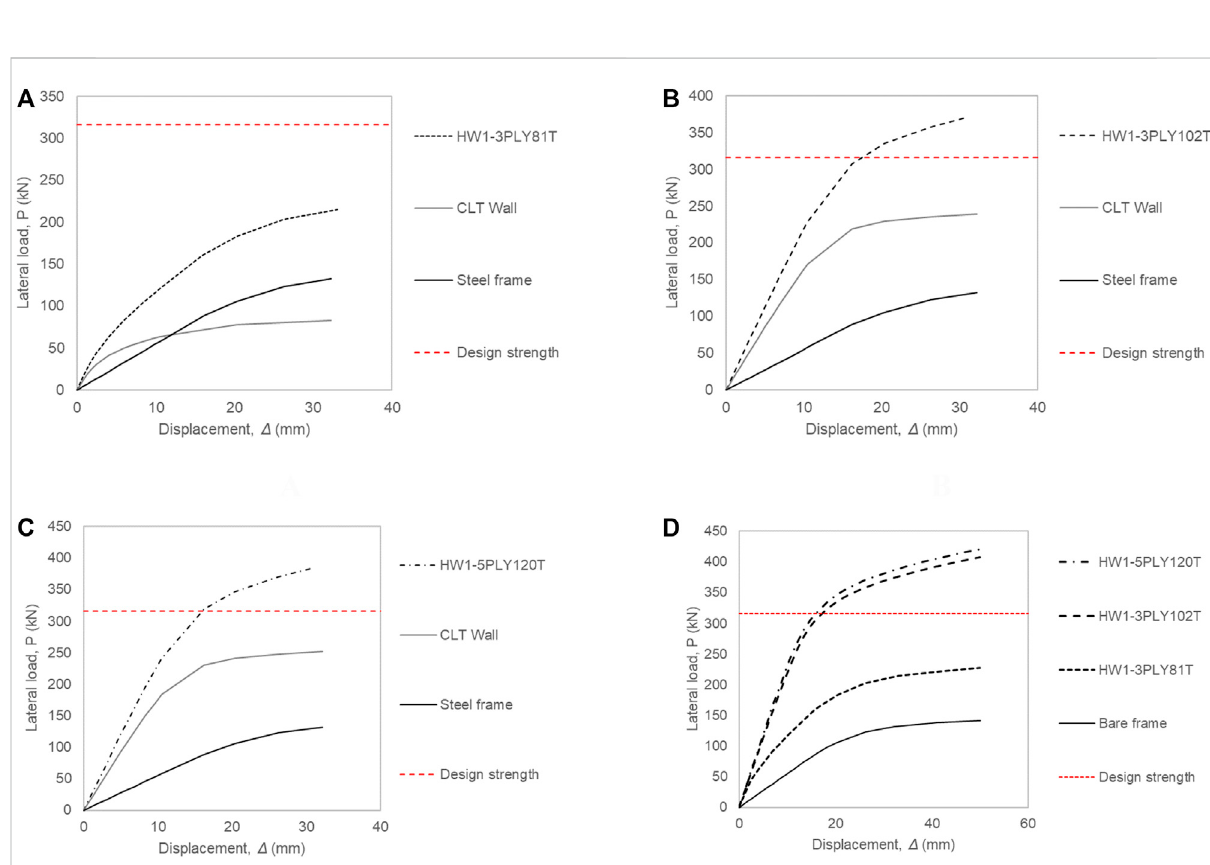
FIGURE 4 BehaviourofSTSWspecimenswithfrictionalin fi ll-frameinterface (A) 3-ply(81mmthick), (B) 3-ply(102mmthick), (C) 5-ply(120mmthick), (D) Comparative diagram.